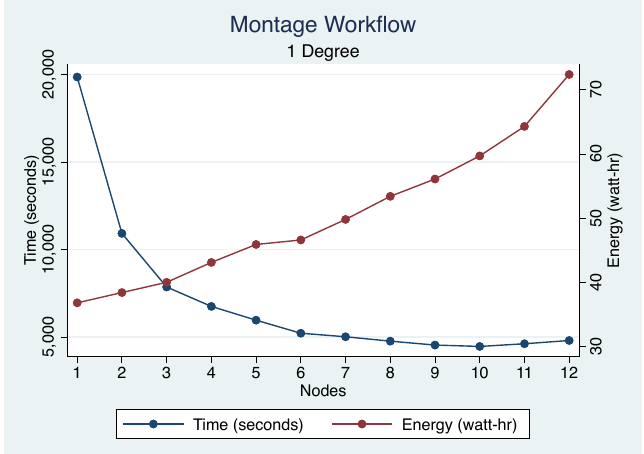
Figure 7. Execution time vs. energy consumption of a Montage 1.0 degree workflow on varying size of